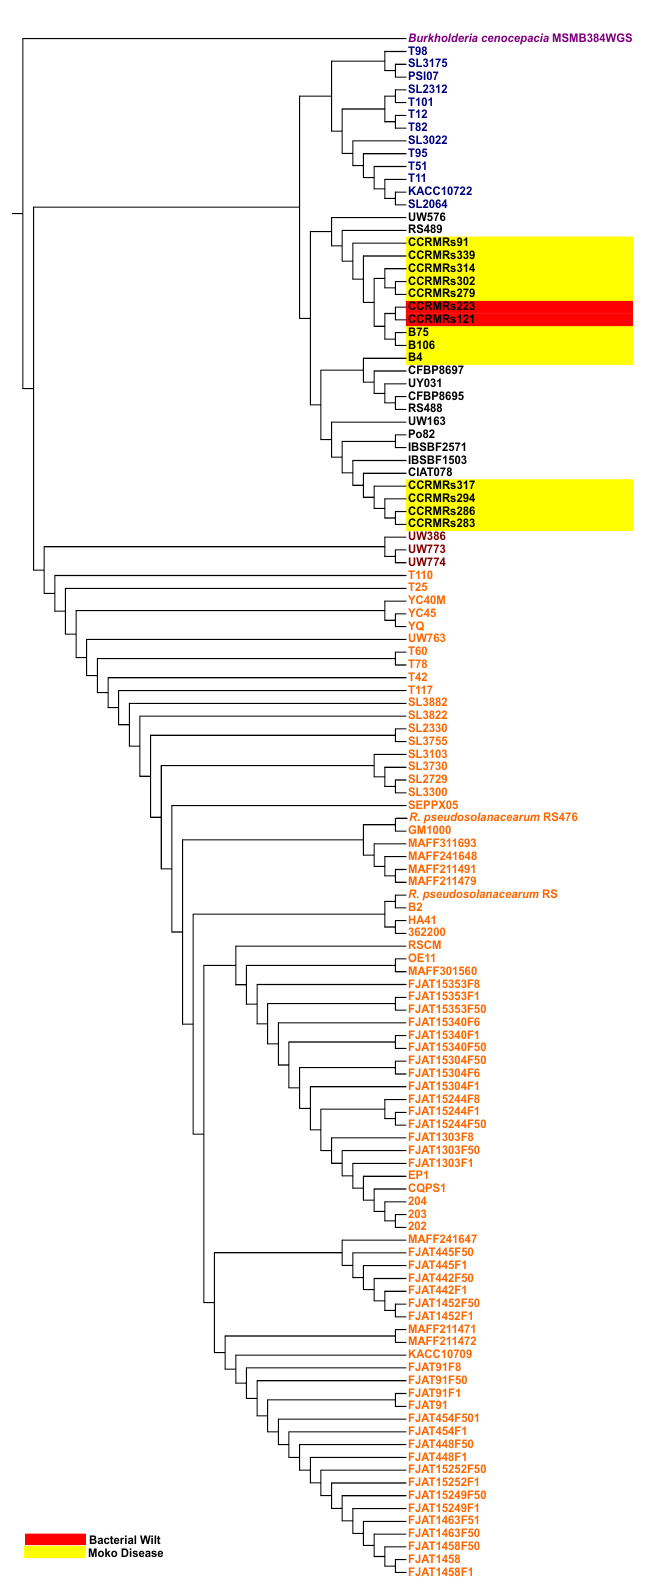
Figure 7. Phylogenomic tree of R. solanacearum species complex (RSSC) strains used in this work. Strains’ names are colored according to Figure 6 pattern: phylotypes I in orange, phylotypes III in brown, phylotypes IV in blue, and phylotypes II in black. Newly sequenced genomes are also highlighted according to their respective